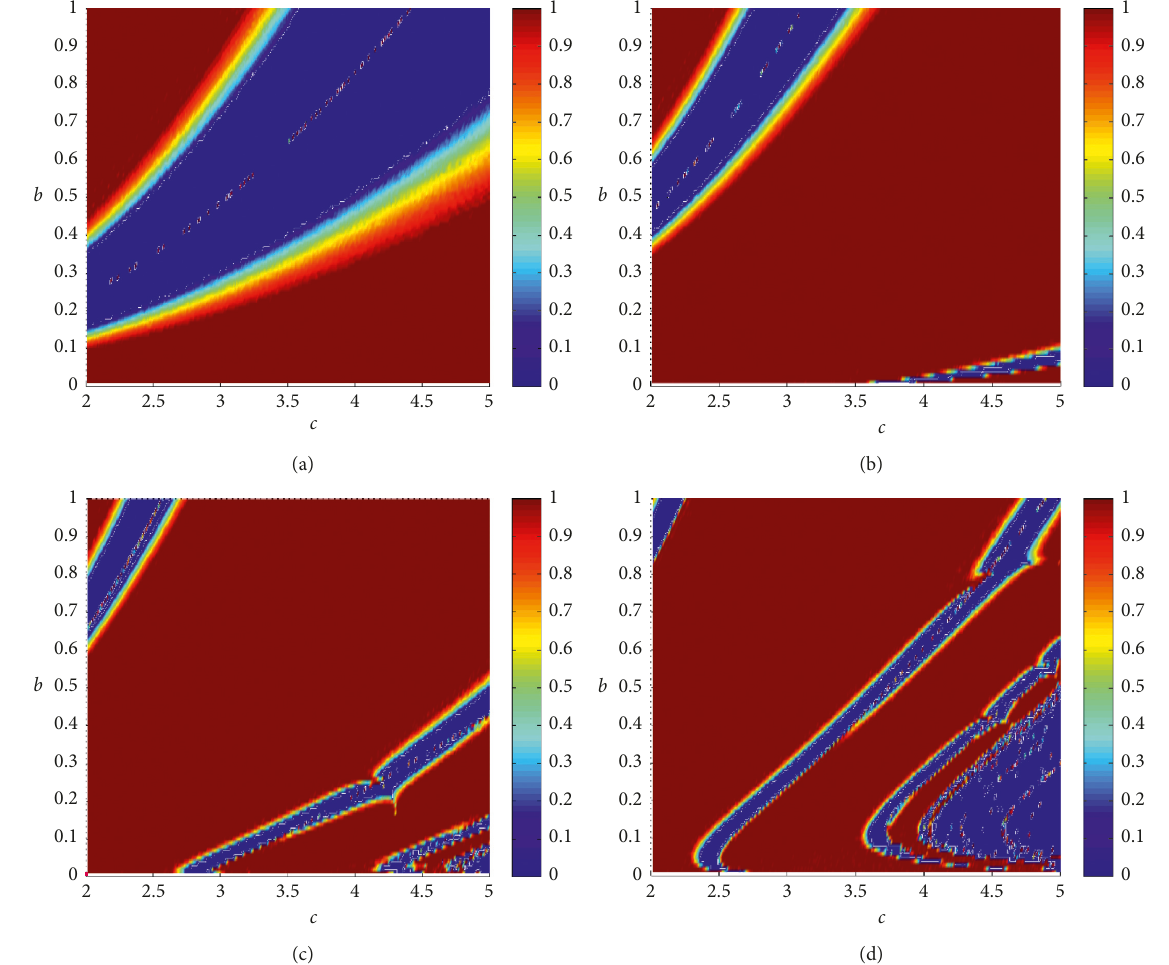
Figure 4: Periodicity of R¨ossler dynamic system. (a) a